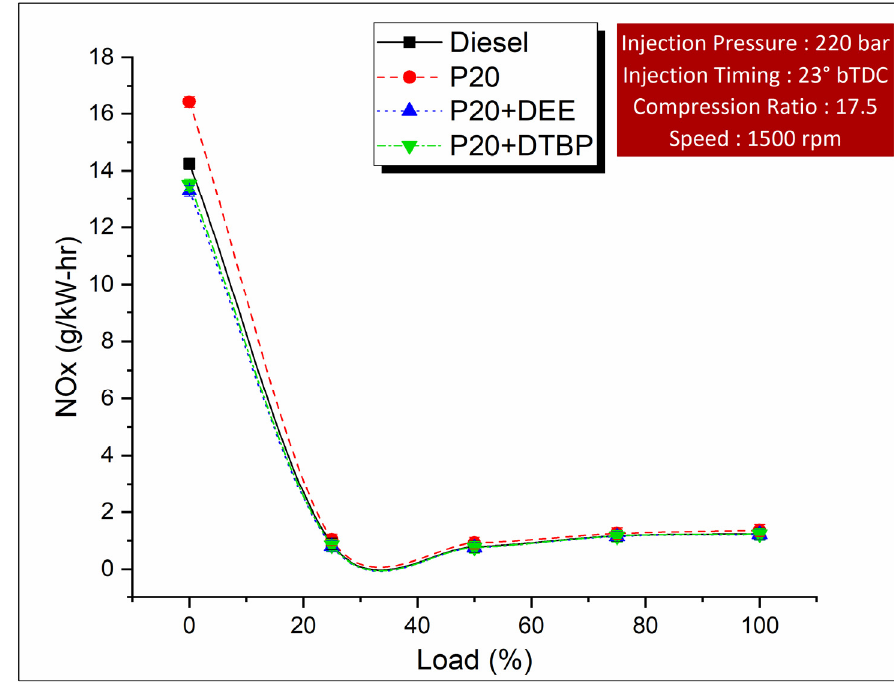
Figure 9. NO x variation for test fuel blends at different load condition.